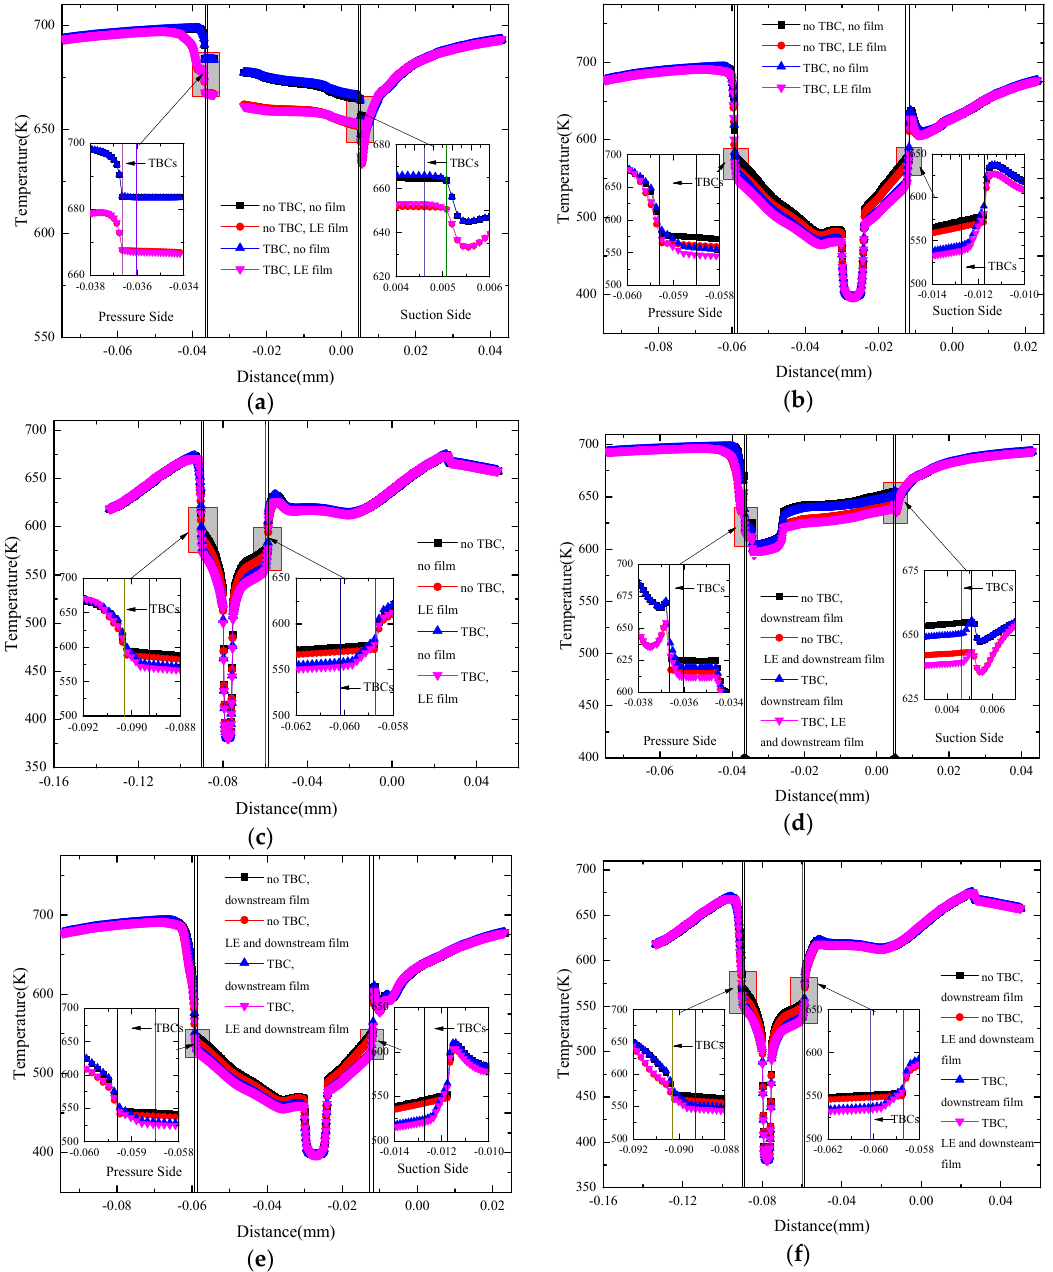
Figure 9. Temperature distribution comparisons for different cases. ( a ) x = 0.25 C ax , ( b ) x = 0.5 C ax , ( c ) x = 0.75 C ax , ( d ) x = 0.25 C ax , ( e ) x = 0.5 C ax , ( f ) x = 0.75 C ax .